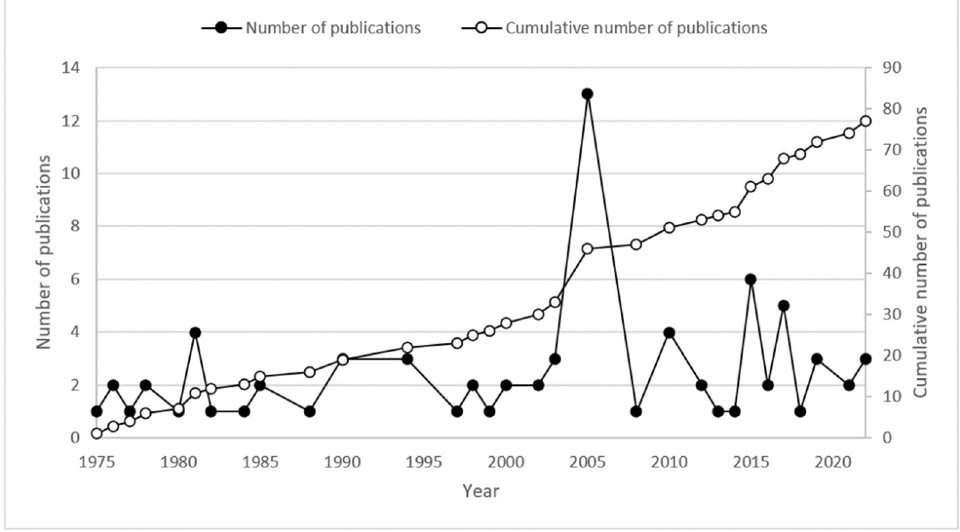
Figure 1. Number of publications and cumulative number of publications on oil spills in ice-infested waters according to the year. Table 7. Top 5 most productive authors publishing on oil spills in ice ‐ infested waters.